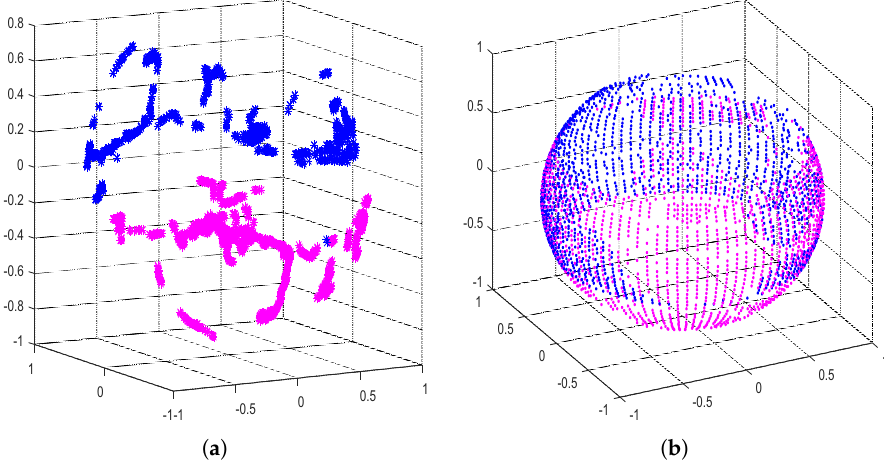
Figure 9. Matching points in the panoramic mirrors (best seen in color). Pink points denote the features in the panoramic upper mirror PMU, and blue points are the features on the panoramic lower mirror PML. ( a ) Shows Harris corners on the mirrors, and ( b ) shows the DeepMatching points on the mirrors.